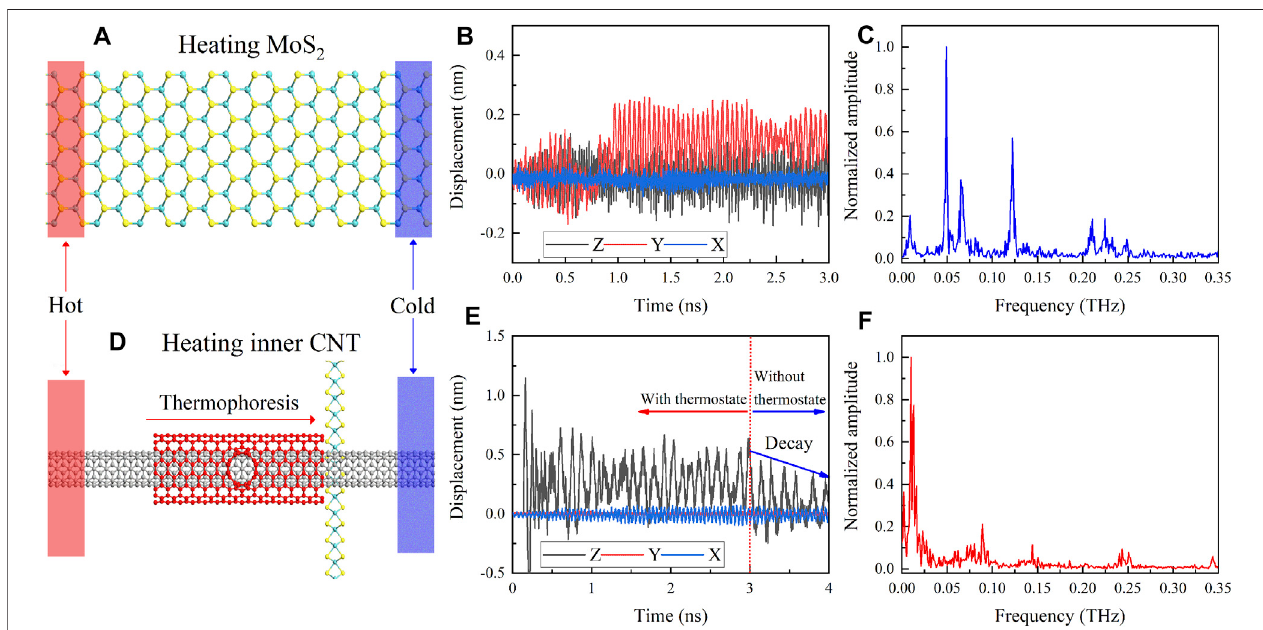
FIGURE 3 | (A) Heated bath at both ends of the MoS (B) the vibration trajectory and (C) the vibration frequency distribution when observed from the 2 nanoribbon: centerareaoftheMoS 2 nanoribbon. (D) HeatedbathonbothendsoftheinnerCNT. (E) VibrationtrajectoryoftheMoS 2 nanoribbon.Theleft/rightsideofthereddashed line corresponded to the situation of with and without the heated bath, respectively. (F) Vibration frequency distribution of the MoS 2 nanoribbon when the inner CNT is